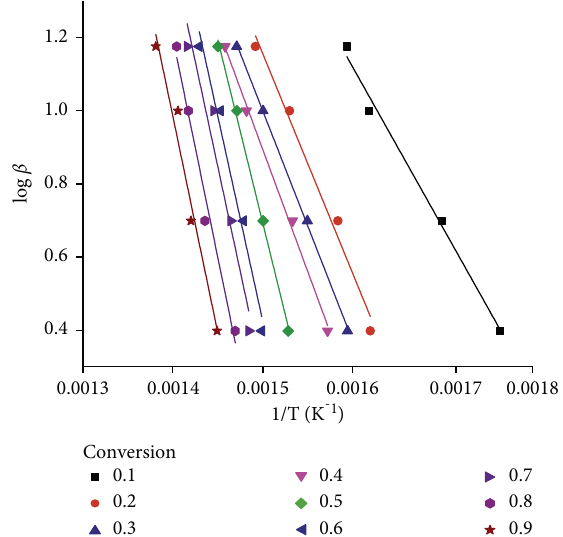
Figure 10: Flynn–Wall–Ozawa plot of ACM-CB60-HNT6 hybrid nanocomposites. Table